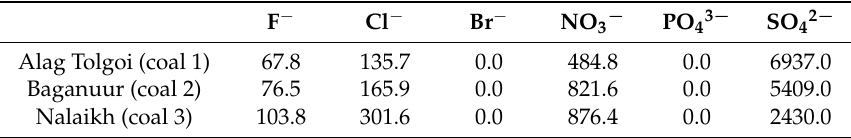
Table 6. Emission factors (mg/kg) of trace anions released during coal